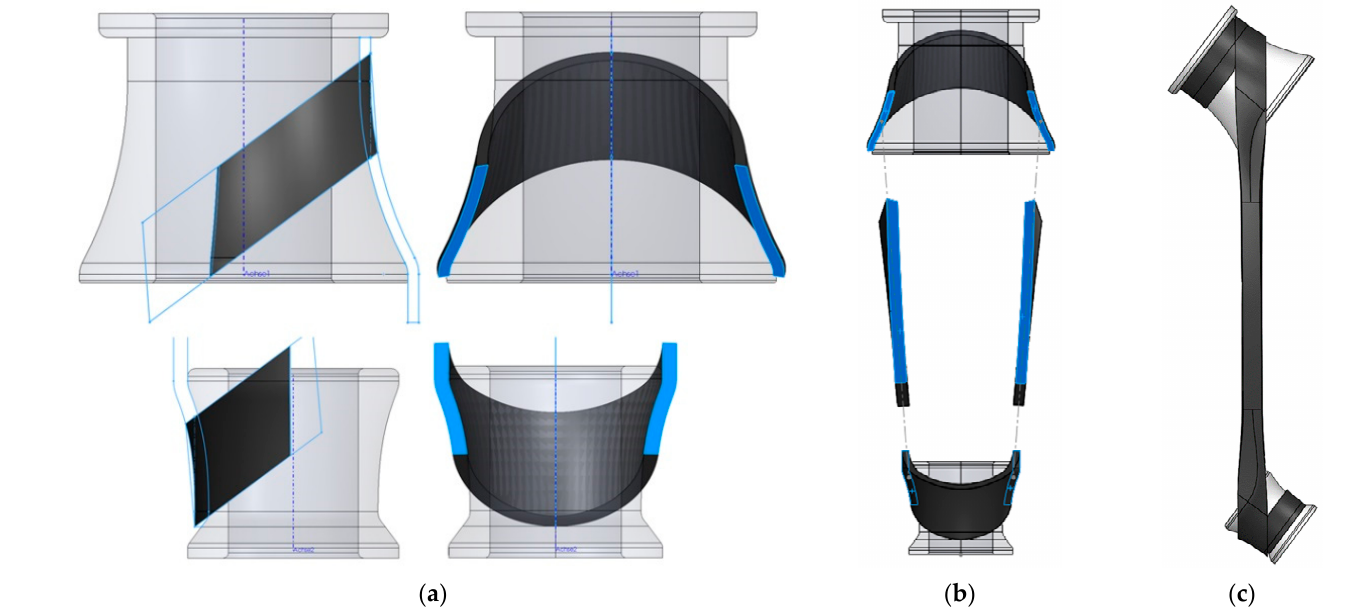
Figure 9. Detailed illustration of the inclined loop model. ( a ) Outer wraps; ( b ) Twisted shafts; ( c ) Inclination angle.